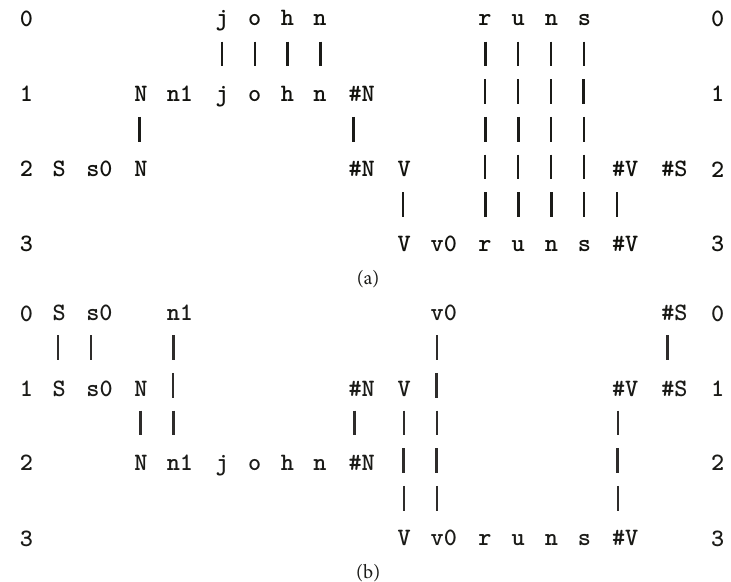
Figure 17: Two SP-multiple-alignments, produced by the SP Computer Model, showing how the program may achieve decompression of information as well as compression of information, as described in the